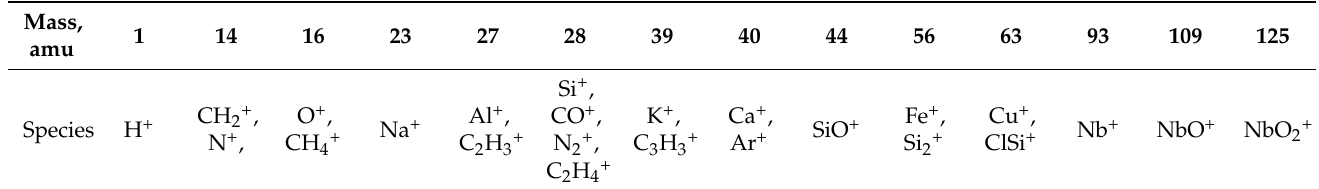
Table 1. Main observed Ions and Fragment Species in SIMS spectra recorded on Niobium after different surface processing (MP, BCP, EP).